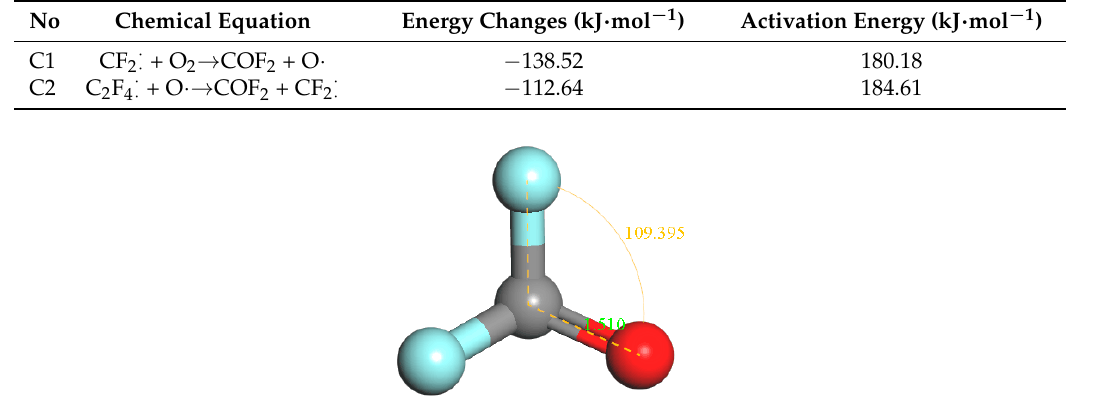
Figure 13. COF 2 molecular structure model.